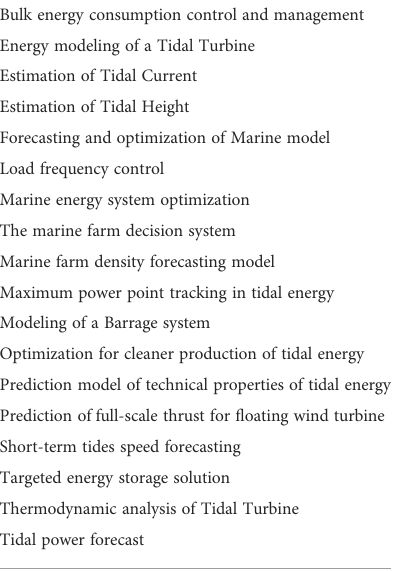
TABLE 2 Objectives on tidal energy system with the application of arti fi cial